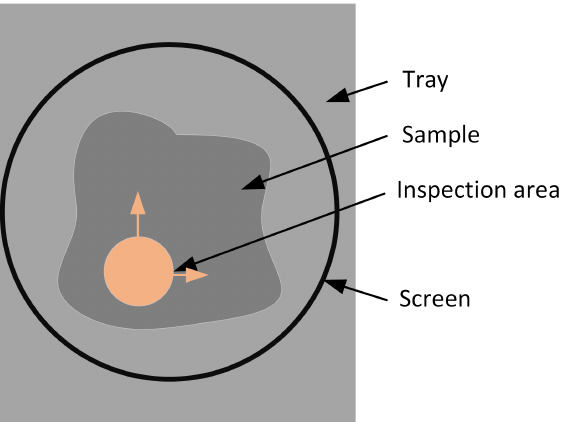
Figure 7. IR image acquisition from an ore sample for the first approach (with macro